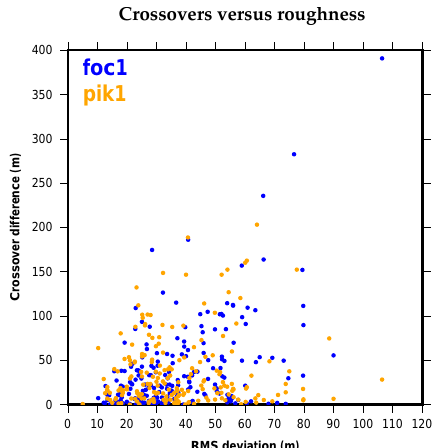
Figure A1. Relationship between RMSD at 800m length scale (as measured in the focused bed elevation data) and crossover differ- ence in bed elevation. The focused data (foc1) has larger outliers in rough terrain, as one direction is actually more correct; for the un- focused data (pik1), the crossover is smaller, as both directions are equally